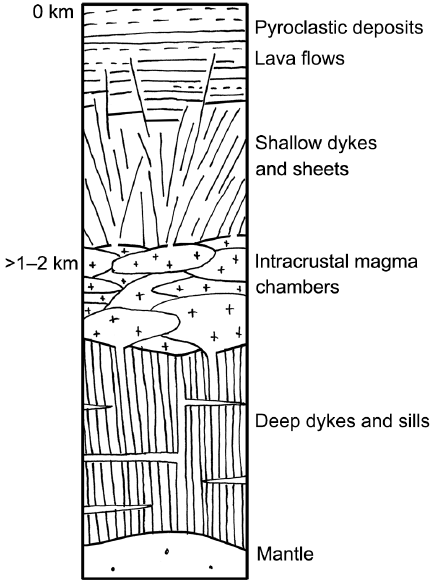
Figure 3. Typical stratigraphy of the Icelandic crust. Pyroclastic rocks, lava flows, shallow dykes and sills, and intracrustal magma chambers are characterized in our study as potential host rocks for geothermal